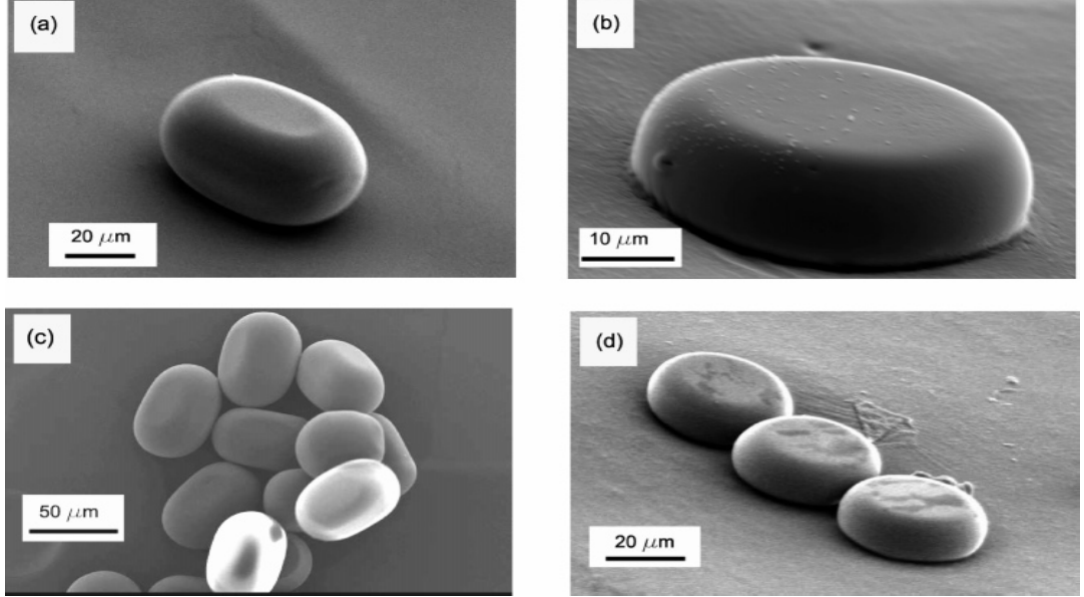
Figure 28. SEM images of non-spherical colloids formed under varying conditions ( a ) plug formed at Q = 0.05 í L/min and Ca = 1.6 × 10 − 3 ; ( b ) disk formed at Q = 0.05 µL/min d d = 0.05 µL/min and Ca = 1.6 × 10 − 3 ; and Ca = 4.8 × 10 − 3 ; ( c ) collection of plugs formed at Q d ( d ) collection of disks formed at Q = 0.05 µL/min and Ca = 9.6 × 10 − 3 d